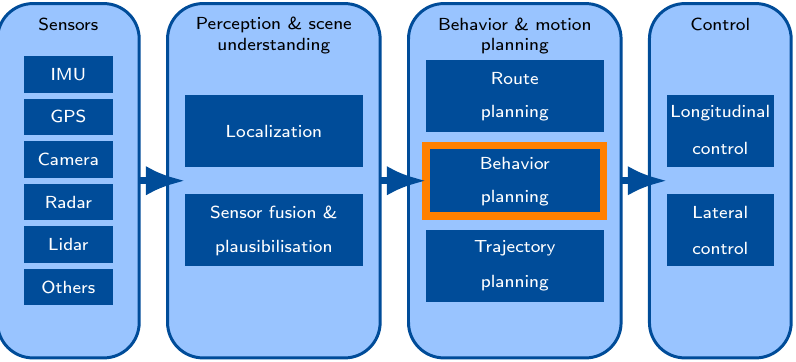
Figure 4. Simplified high-level architecture for self-driving vehicles following the conventional approach of most OEMs and Tier1s. See text for